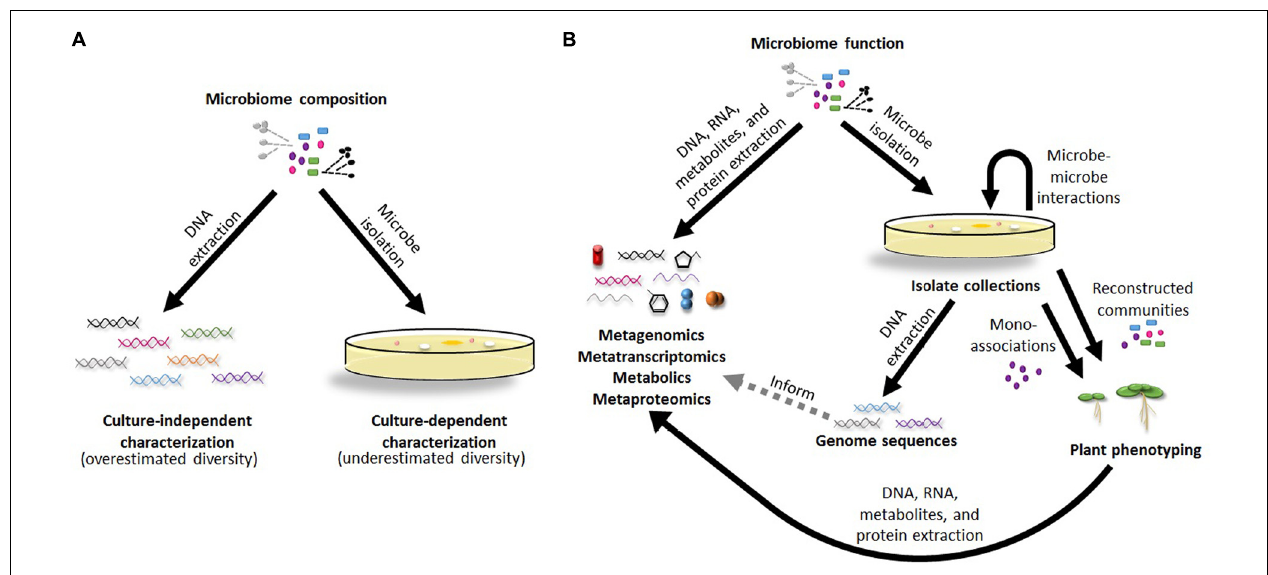
FIGURE 1 | Methods for characterization of plant microbiome composition and function. (A) Culture-dependent and culture-independent methods are the two major approaches used to determine the microbial make-up of plant microbiomes with each having its own limitations in